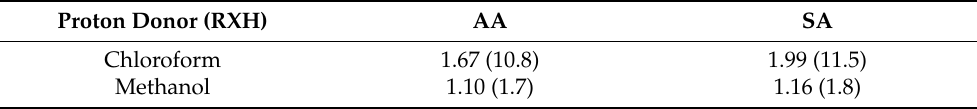
Table 4. The parameters A b of alanine (AA) and sarcosine (SA) anhydride with methanol in the media chloroform and alcohols.